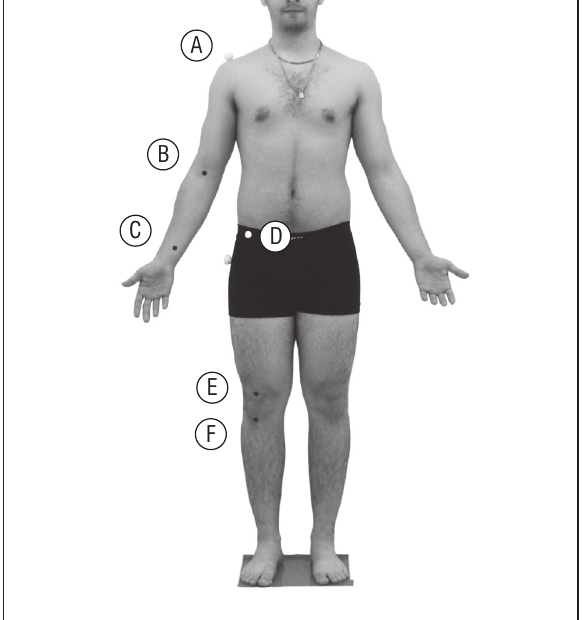
Figura 2 - Marcos anatômicos de referência para mensura- ção angular em vista anterior Legenda: Pontos: A = acrômio; B = inserção do tendão do bíceps braquial; C = ponto médio entre rádio e ulna distal; D = espinha ilíaca ântero-superior; E = centro da patela; F = tuberosidade da